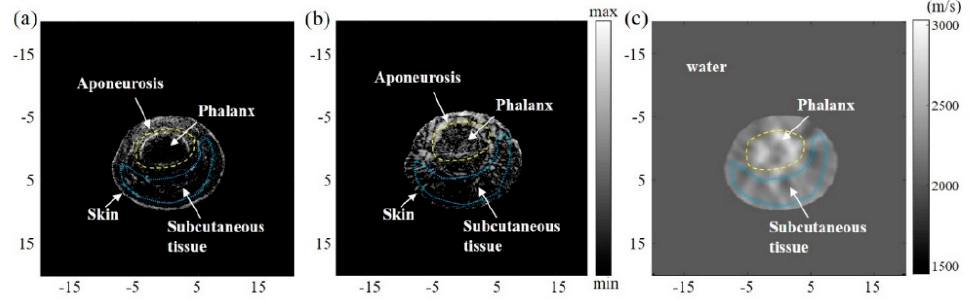
Figure 6. In vivo experimental results. ( a ) The reflection image from the constant acoustic speed of 1495 m/s. ( b ) SoS adaptive reflection image in USCT. ( c ) SoS map derived from the transmis- sion